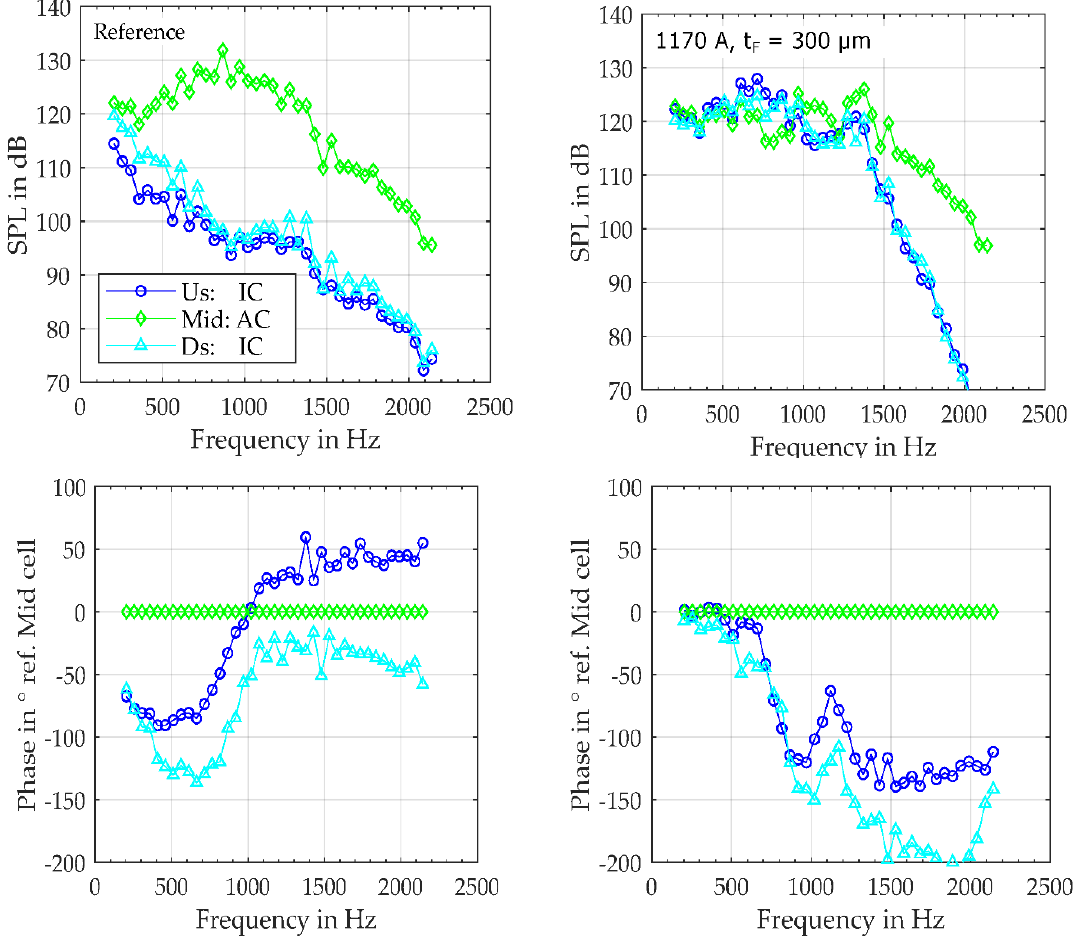
Figure 10. SPL values ( upper row ) and phase information referenced to the middle cell ( lower row ) for the reference sample ( left ) and FlexiS liner with TPU1170-0.3 ( right ); (acronyms: Us — upstream, Mid — midstream, Ds — downstream, AC — active cell, IC — inactive cell).